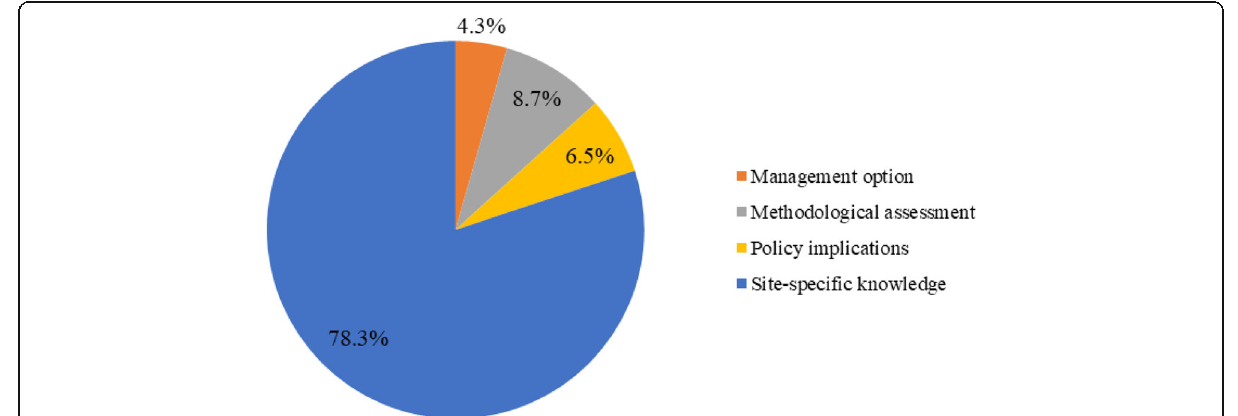
Fig. 7 Main purposes of the selected published